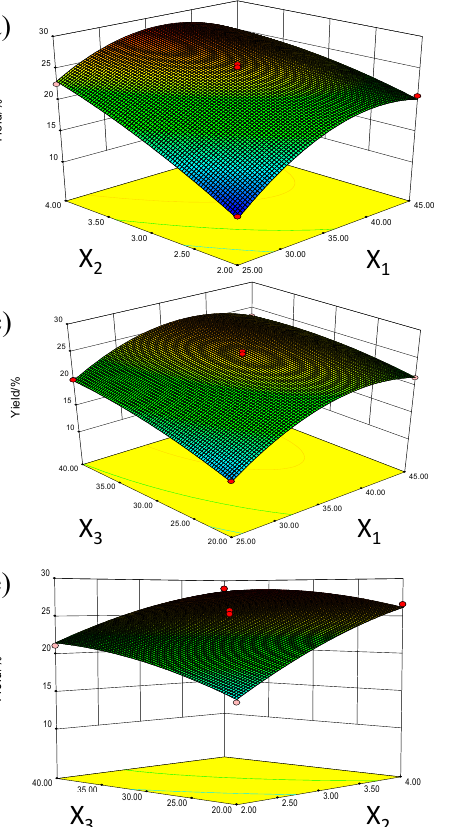
Figure 2. Response surface plots ( a , c , e ) and contour plots ( b , d , f ) of oil yield by extraction temperature ( X 1 ), number of extraction cycle ( X 2 ) and extraction time ( X 3 ).